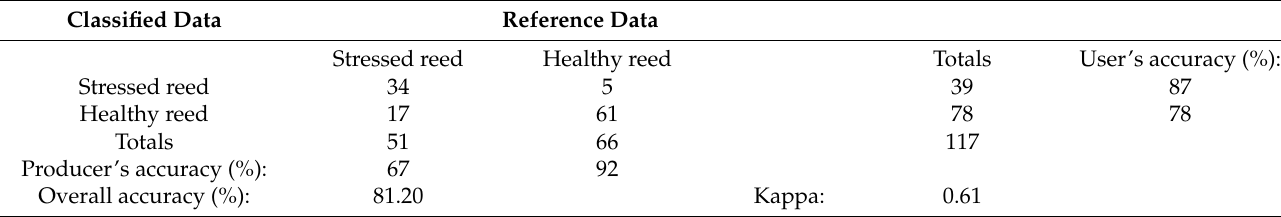
Table 4. Accuracy matrix for the status estimation derived by a combinatorial